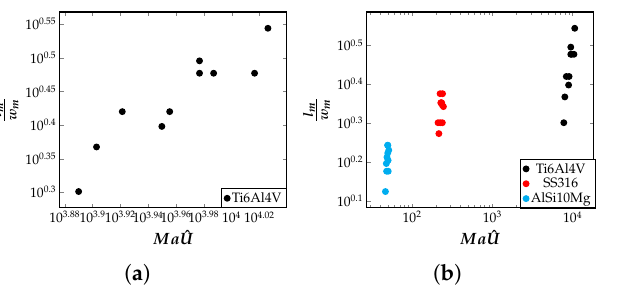
Figure 6. Correlation of the aspect ratio with Ma ˆ U = a 0 Ma + a 1 MaE + a 2 MaPe , plotted on a log–log scale, for ( a ) Ti6Al4V alloy, and for ( b ) three alloys (Ti6Al4V, SS316 and AlSi10Mg) shown in a single plot to demonstrate clustering. A combined plot demonstrating this clustering for all the five alloys (Ti6Al4V, SS316, AlSi10Mg, IN718 and AZ91D) considered in this work can be found in Figure S3 of the Supplementary Information. Each point in these plots represent a single simulation result for the relevant quantities plotted, and is obtained from the FEM